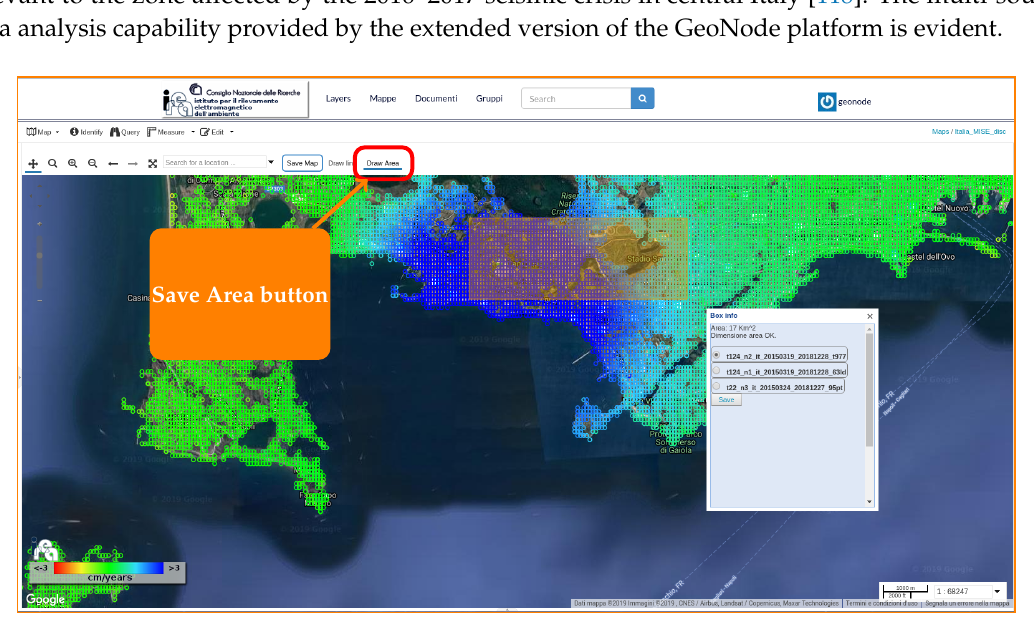
Figure 17. Example of the implemented download web plug-in on a selected area.